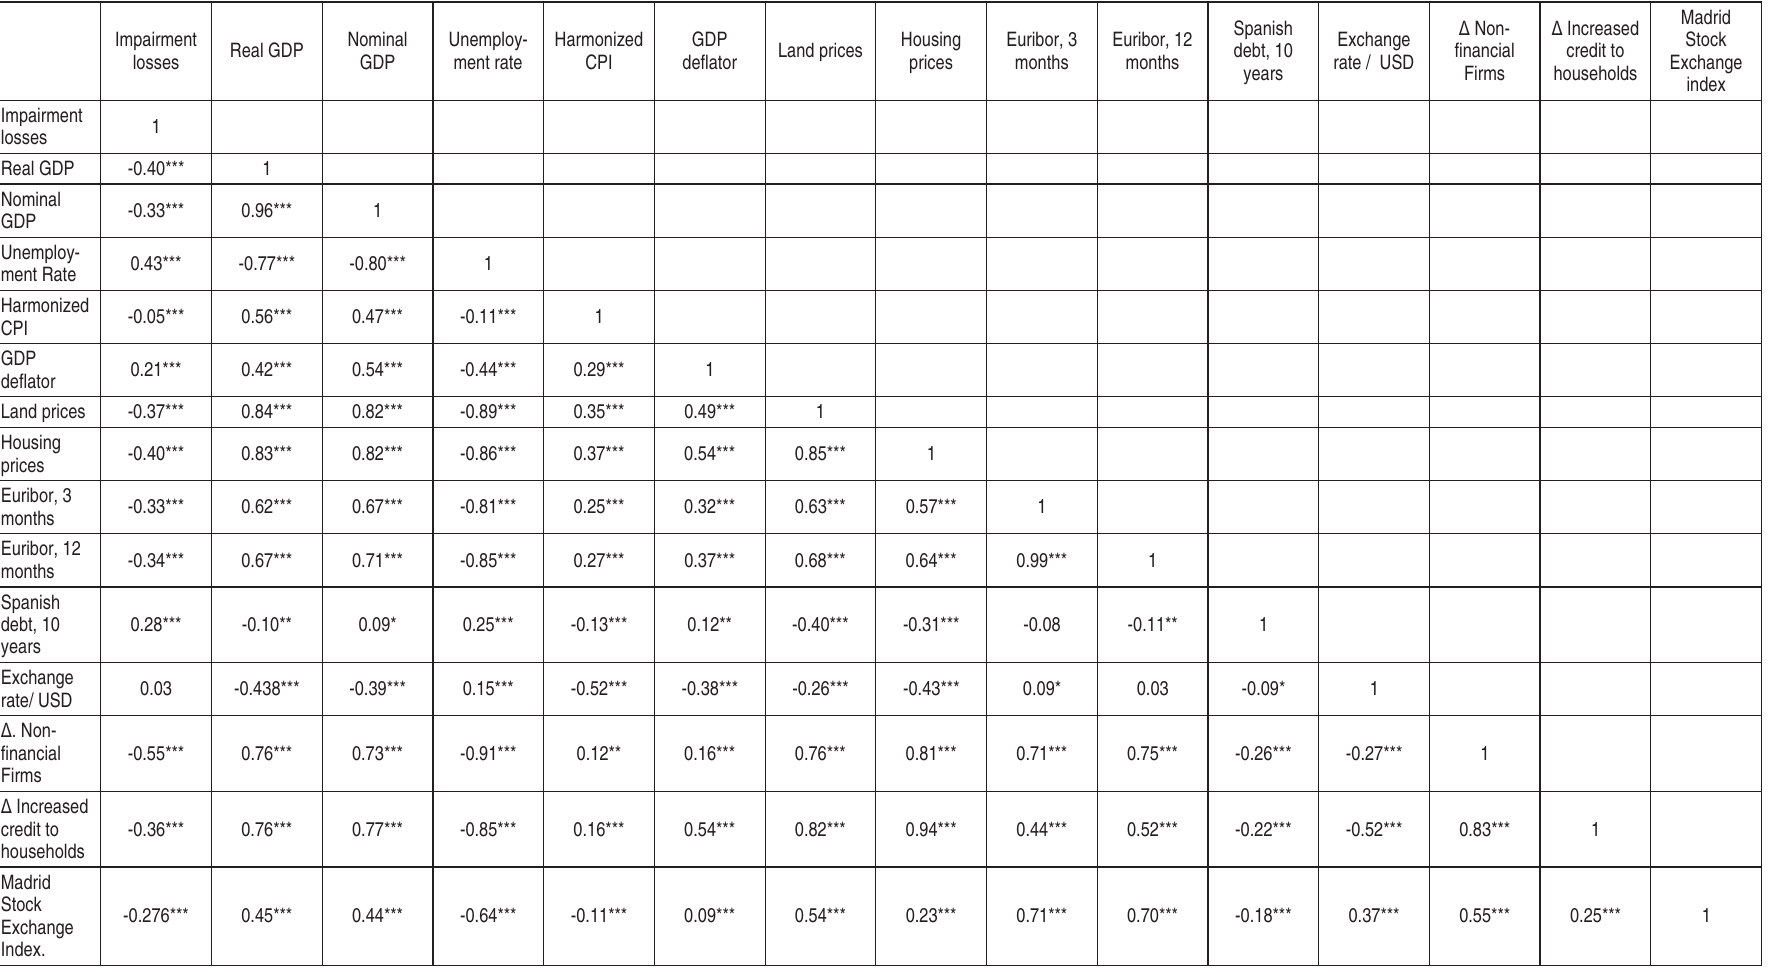
Table 1. Correlations between